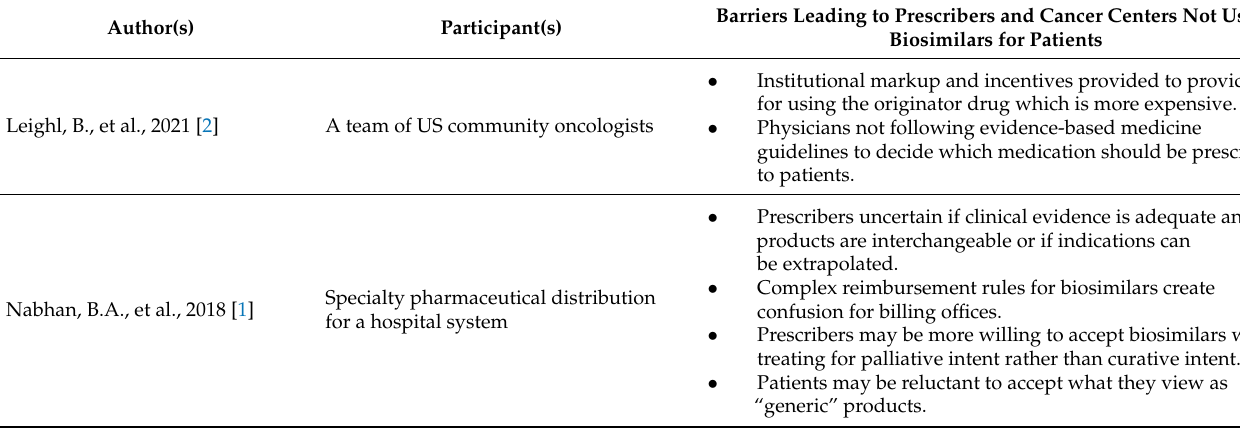
Table 1. Summary of findings ( n = 27).